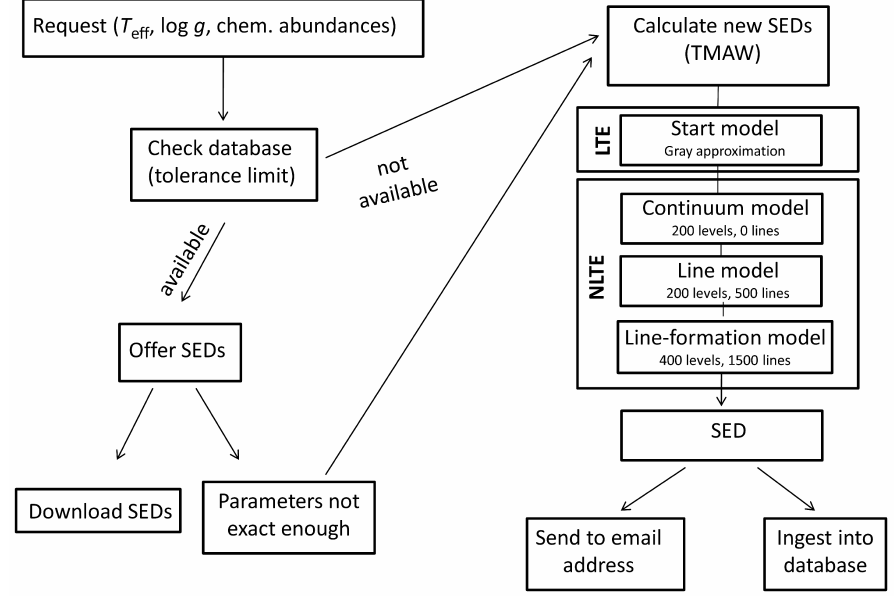
Fig. 4. Scheme of TheoSSA and TMAW with typical level and line